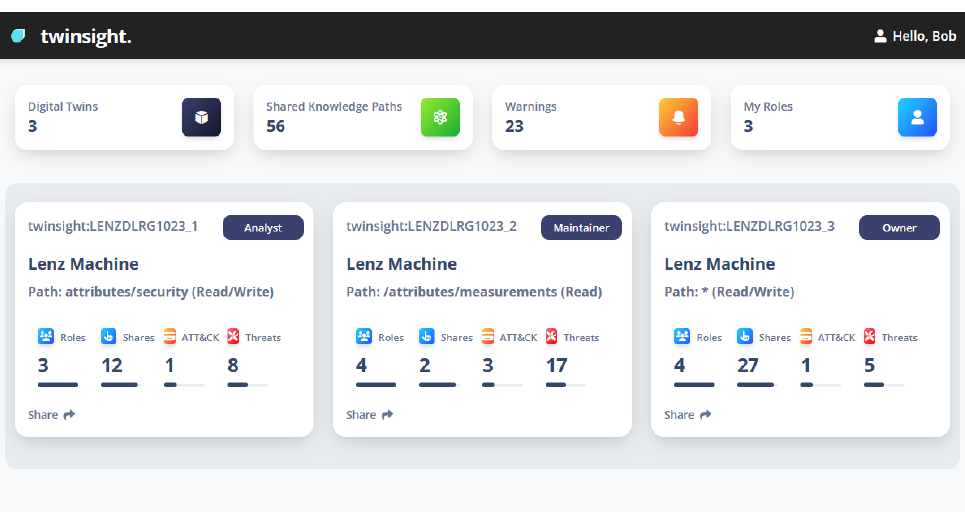
Figure 6. T WINSIGHT UI combining security analytics and digital